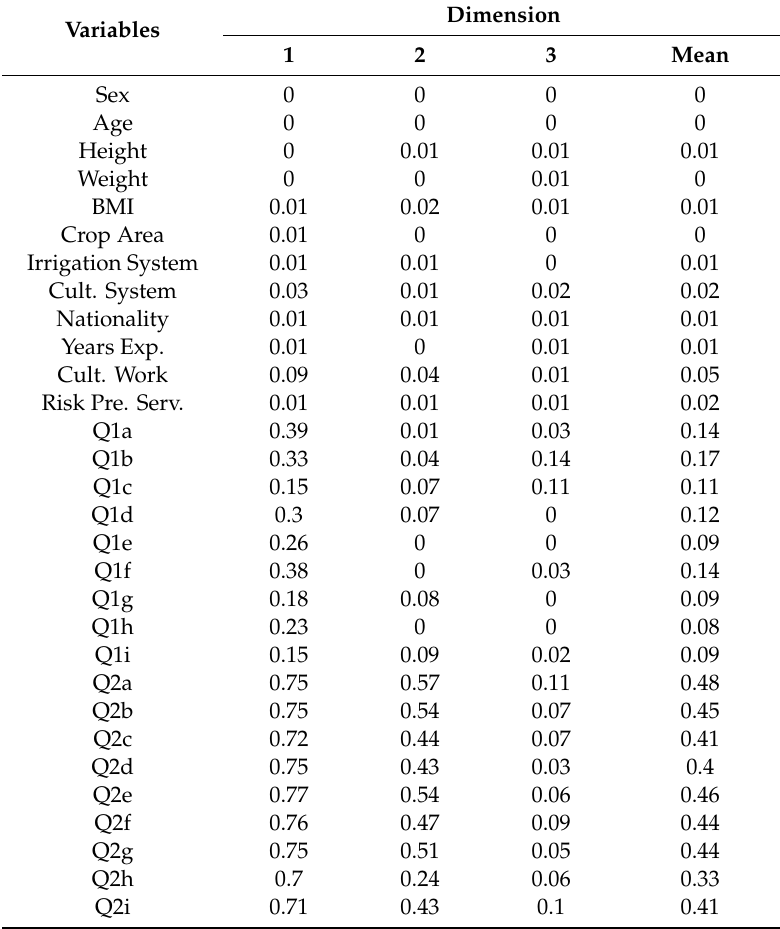
Table 7. Discrimination values for the variables with respect to the three